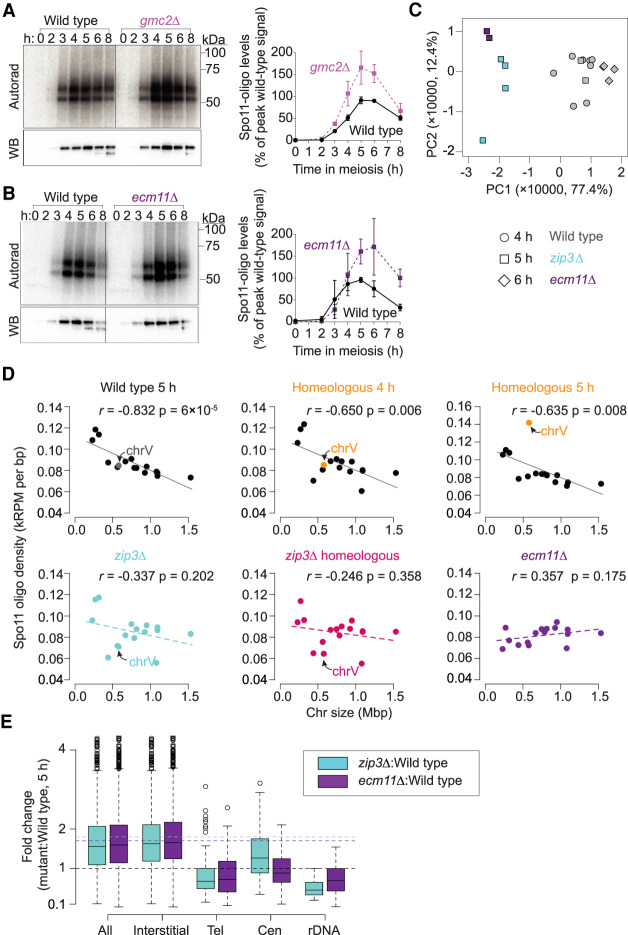
gmc2Δ and ecm11Δ mutants share similar homolog engagement signatures as zip3Δ. (A,B) Representative labeling of Spo11-oligo complexes in gmc2Δ (A) and ecm11Δ (B) mutants and quantification relative to wild-type cultures processed in parallel. Error bars indicate mean ± SD for three cultures. Radiolabeled Spo11-oligo complexes are detected by autoradiography (top, left panel) and total Spo11 is detected by anti-FLAG Western blot (WB; bottom left panel). The two main labeled species differ in the sizes of oligos (Neale et al. 2005). Most Spo11 protein does not end up making DSBs, so nearly all of the visible Western blot signal is from free Spo11 that does not have an oligo attached (Neale et al. 2005). (C) Principal component analysis of 20 wild-type and mutant Spo11-oligo maps. (D) Loss of anticorrelation between chromosome length and DSB density in homolog engagement-defective mutants. Each point is one chromosome. Correlation coefficients (Pearson's r) are shown. (E) Fold change of Spo11-oligo counts in different chromosomal domains. Tel, within 20 kb of telomeres; Cen, within 10 kb of centromeres; rDNA, from 60 kb left to 30 kb right of rDNA; Interstitial, all others. Horizontal dashed lines mark values assumed as no change (black) and average change (1.8-fold for zip3Δ [cyan]; 1.7-fold for ecm11Δ [purple]). Boxes indicate median and interquartile range, whiskers indicate the most extreme data points that are ≤1.5 times the interquartile range from the box, and individual points are outliers.